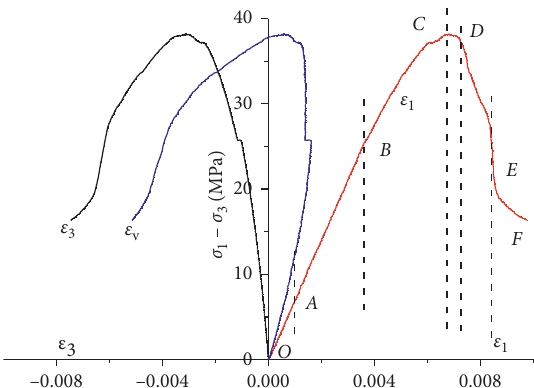
Figure 2: Stress-strain curves of coal from triaxial compression